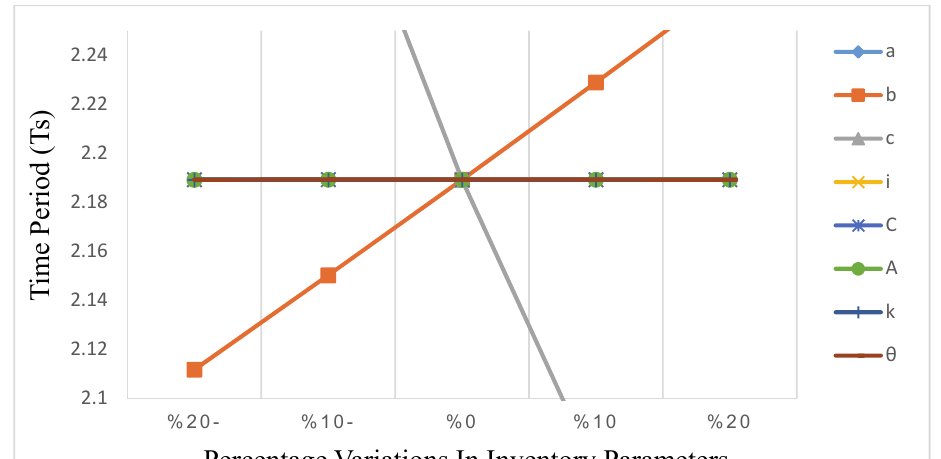
Fig. 8. Variations in time period